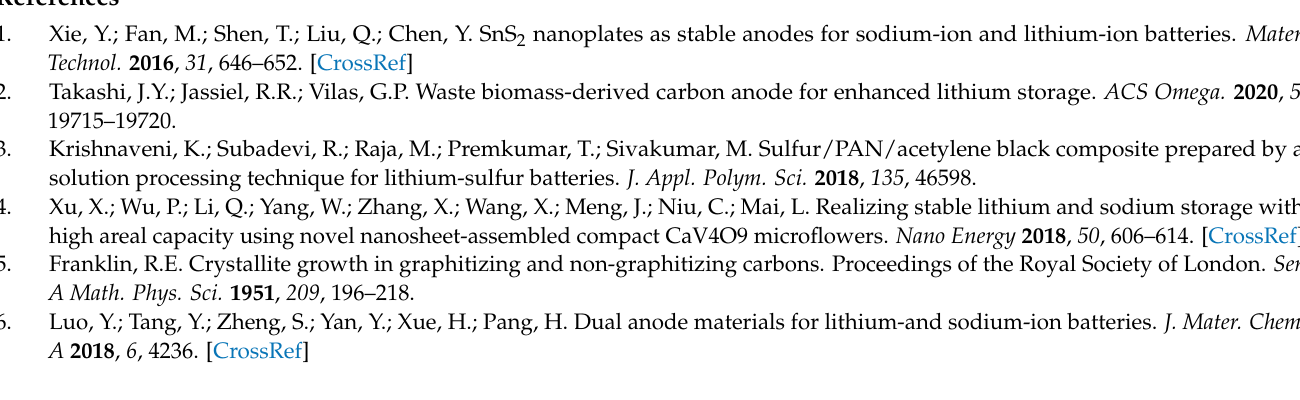
Width; Figure S2: Bar graph for various fibers and their elongations; Figure S3: XRD pattern of Raw MaF; Figure S4: Raman spectra of Raw MaF; Figure S5: Nitrogen adsorption and desorption of raw MaF; Figure S6: Pore size distribution of raw MaF; Figure S7: Nitrogen adsorption plot for Na − MaFDHC and Zn − MaFDHC; Figure S8: SEM image of raw MaF; Figure S9: TEM image of Raw MaF; Figure S10: Nyquist plot of Raw MaF; Figure S11: XRD images of Na − MaFDHC and Zn − MaFDHC after 100 cycles. Table S1: Physical property of natural fibers; Table S2: Sodium-ion Diffusion coefficient of MaFDHC